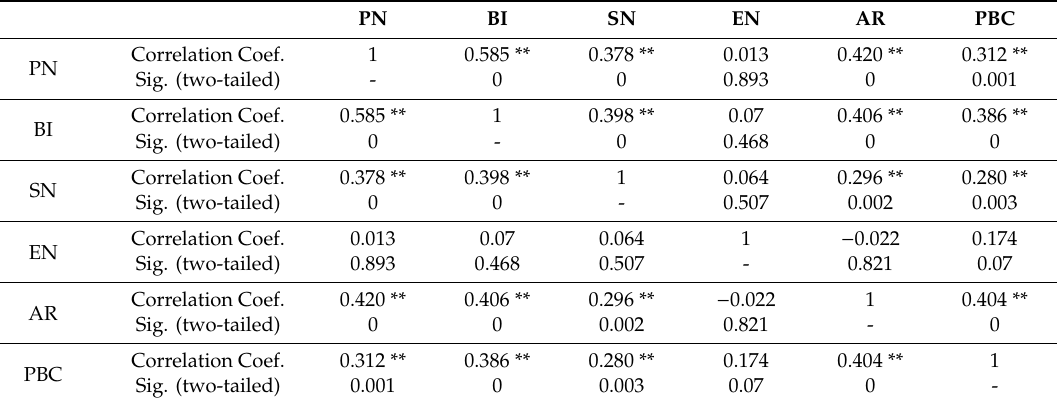
Table 15. Correlation analysis